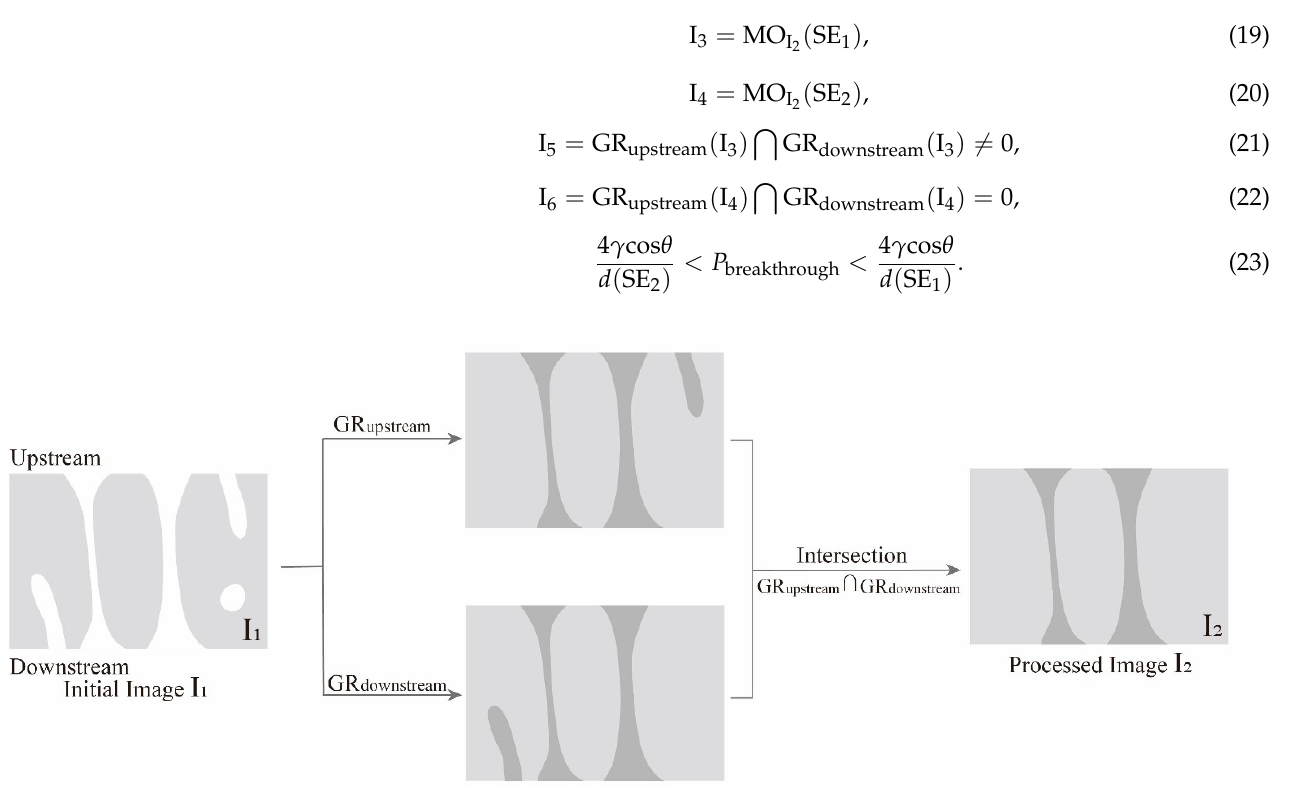
Figure 13. Step 1: extraction of the interconnected pathways.